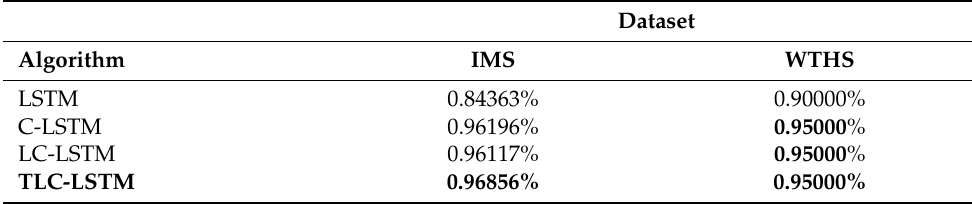
Table 2. Classification rates of HS